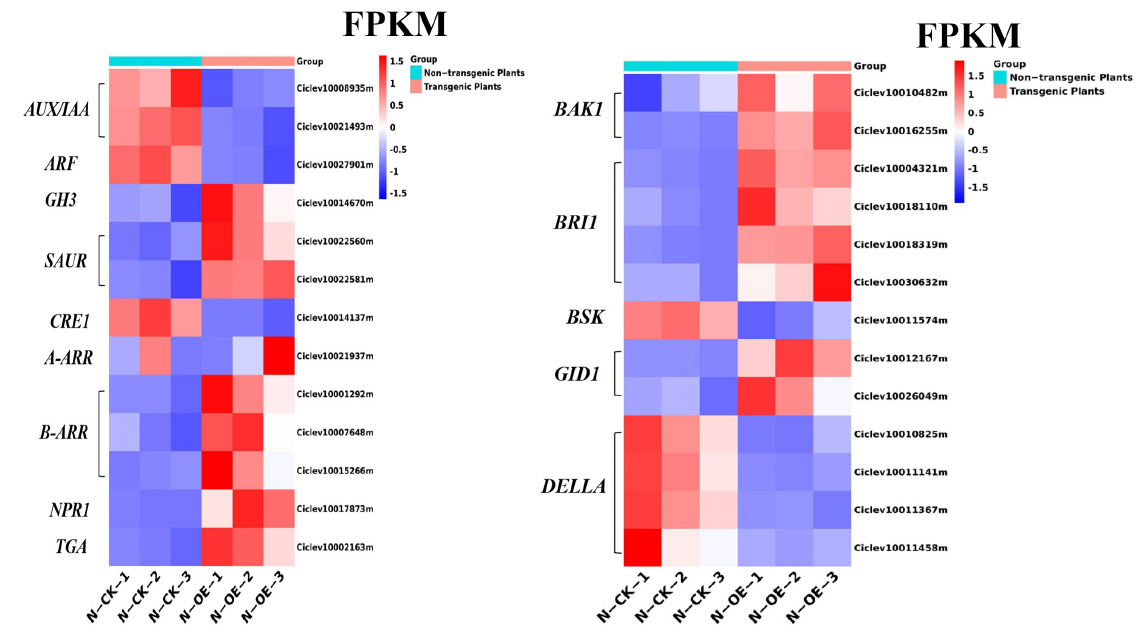
Figure 11. The FPKM of the DEGs in the plant hormone signal transduction pathway in the non- transgenic plants versus the transgenic